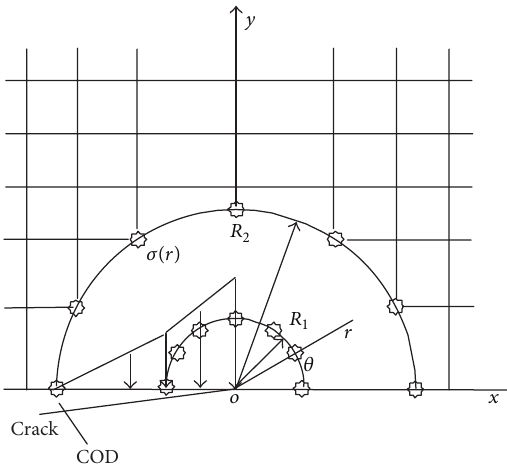
Figure 4: Crack-singular-analytical element loaded by the linear cohesive